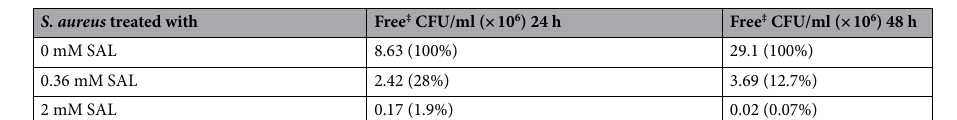
Table 1. Bacteria dispersed from biofilm. ‡ Number of floating viable bacterial cells from biofilm grown during 24 or 48 h in the presence or absence of SAL normalized to the initial CFU/ml.